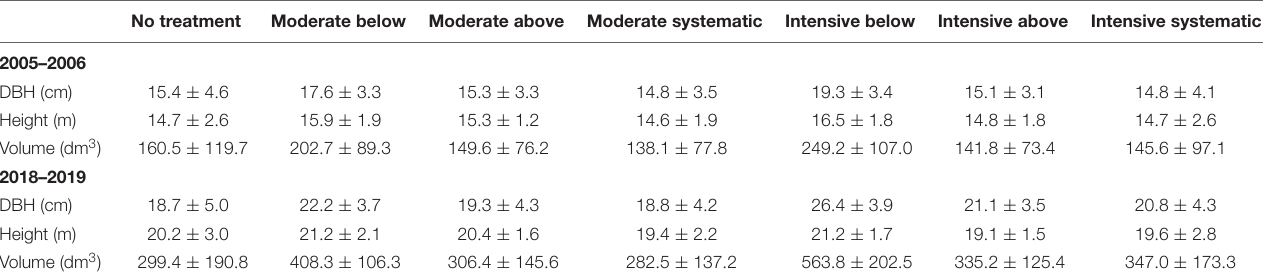
TABLE 2 | Mean tree-level attributes with their standard deviation (with ± ) for each treatment at the year of the establishment (2005–2006) and after the growth period (2018–2019). No